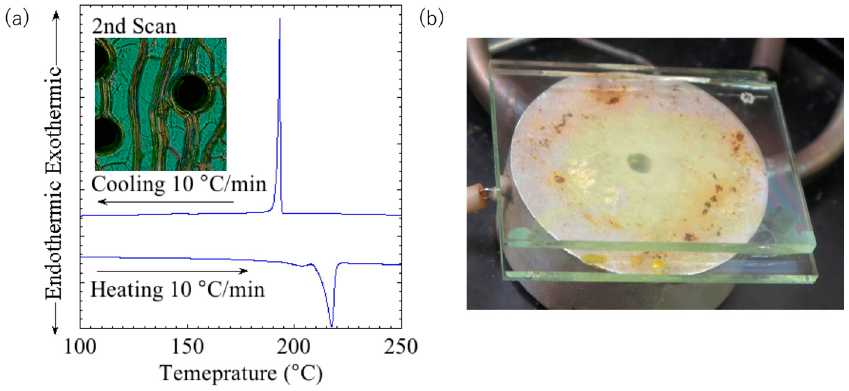
Figure 1. Chemical structure of the compound used in this study.